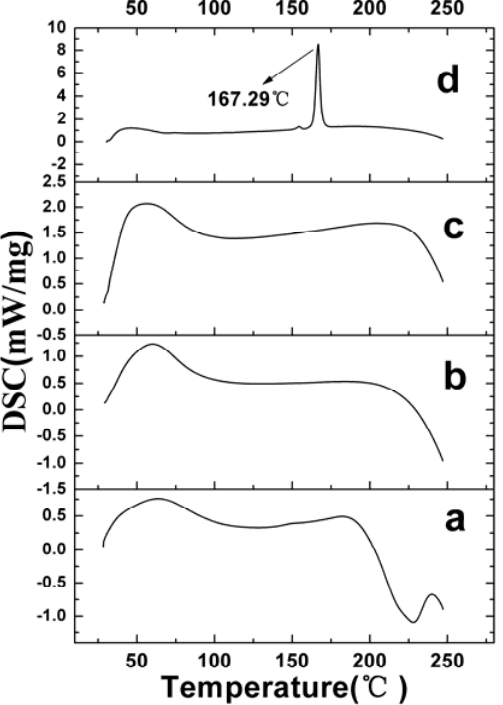
Figure 6. Differential scanning calorimetry (DSC) patterns of raw VLBT and VLBT-loaded nanoparticles. ( a ) Raw VLBT; ( b ) VLBT-BSANPs; ( c ) Fa-BSANPs-VLBT ; ( d ) Fa-BSANPs-VLBT with mannitol.